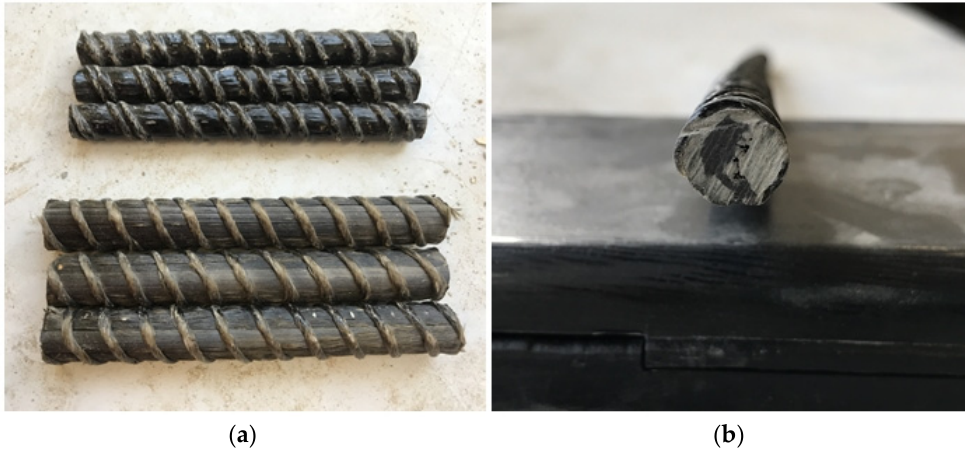
Figure 3. FRP bar imperfections: uneven coverage of epoxy resin on surface of bars ( a ) variable distance of the carbon core from the bar edges ( b ).